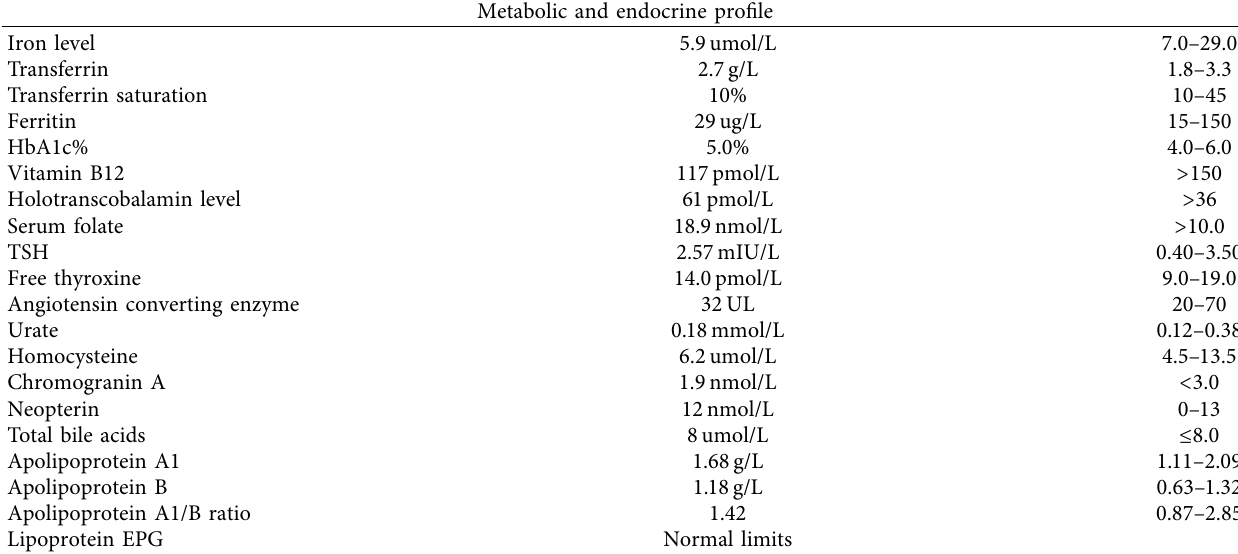
Table 4: Metabolic and endocrinologic